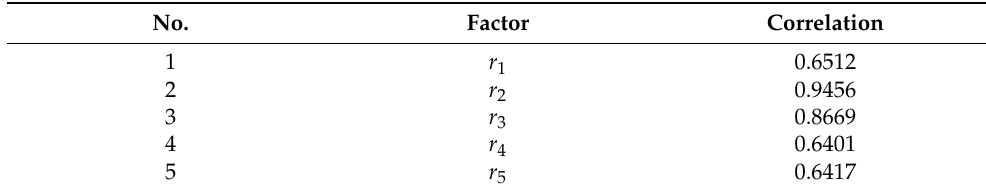
Table 3. Grey correlation between each influencing factor and the current water level in front of the pumping